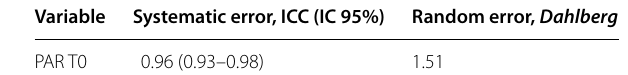
Table 3 Systematic error and 95% confidence interval for the intraclass correlation coefficient (ICC) and the random error of the variable PAR T0